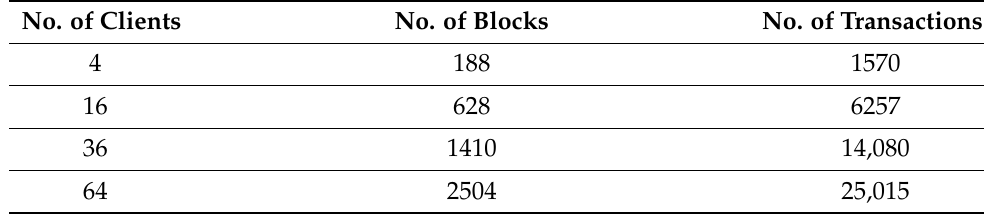
Table 4. Signature checking-single host.